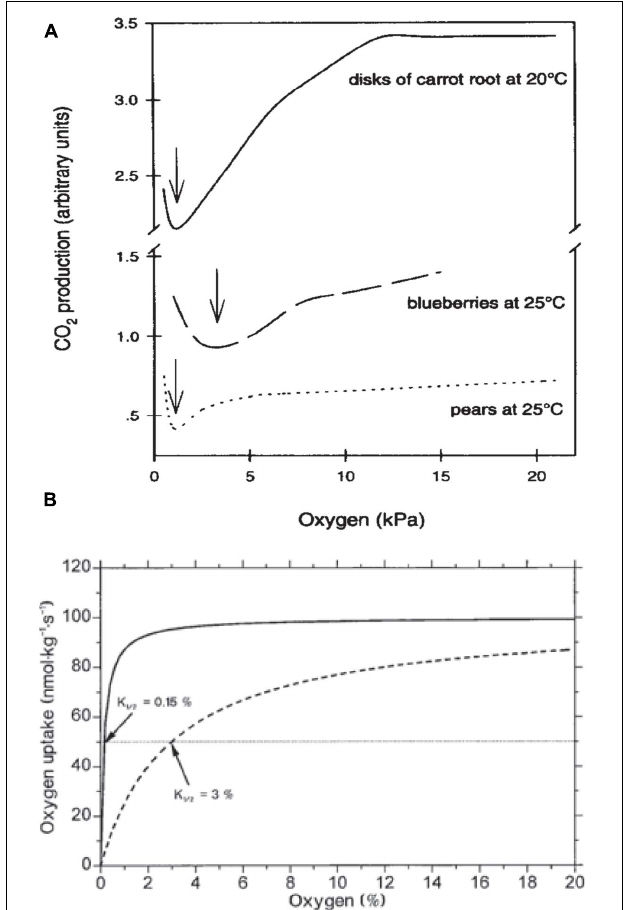
FIGURE 3 | (A) Plant CO 2 production in response to oxygen depletion. Data on carrot are from Leshuk and Saltveit (1990), on blueberries from Beaudry et al. (1992) and on pears from Boersig et al. (1988). Arrows indicate ACPs (Chervin et al., 1996, with permission of Elsevier). (B) Hypothetical respiratory responses to O 2 for a respiratory system of low diffusive resistance exhibiting a K 1 / 2 of about 0.15% O 2 , representative of single cells or tissues, and a tissue with significant diffusive resistance to gas exchange with an K 1 / 2 of 3% O 2 (with open